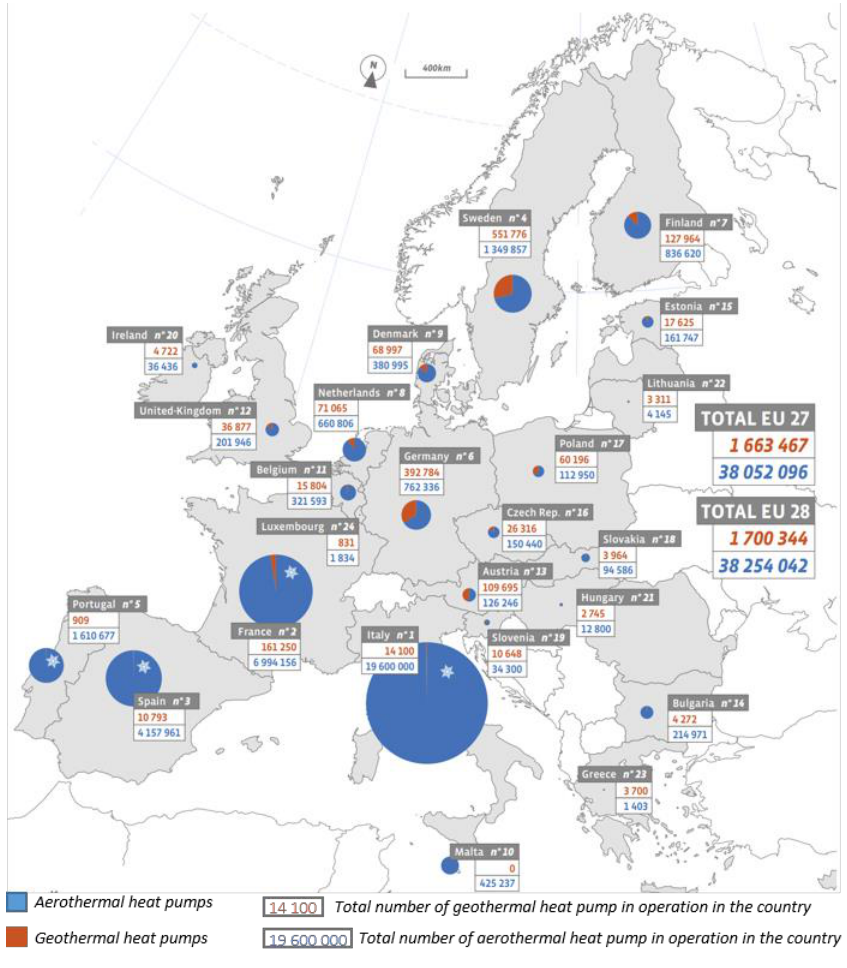
Figure 1. Air-source and ground-source heat pumps in the European market [7].